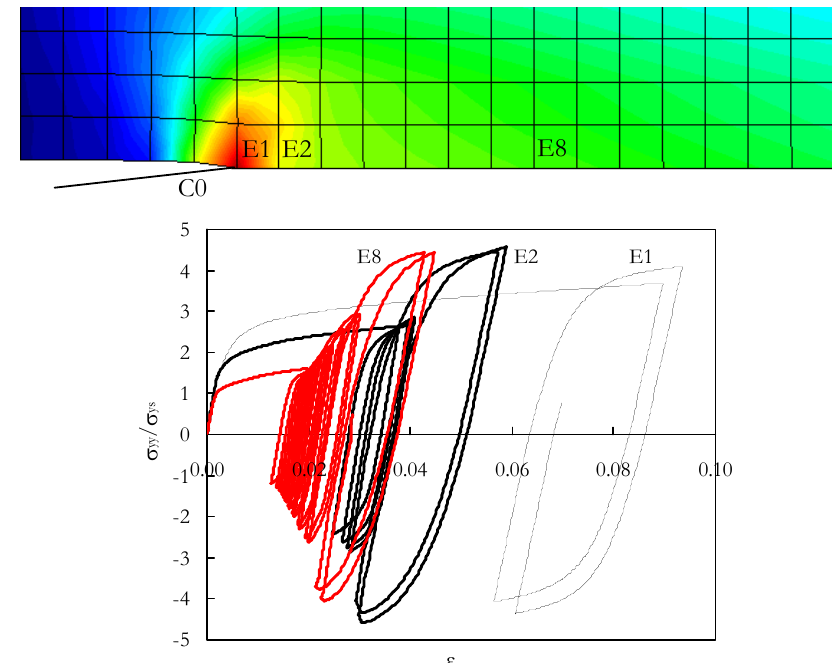
Figure 4: Equivalent plastic strain along crack flank (Mixed hardening,  max =47.5 MPa;  min =0.8 MPa).